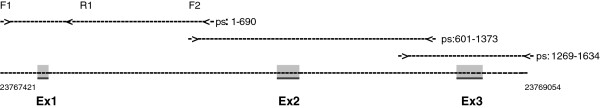
Schematic presentation of primer positions on the rabbit CCL8 ortholog. Primers were designed to cover all exon and intron regions of the proposed Rabbit ortholog of the Human CCL8 gene (1634 bp) [Genbank NC_013687.1:REGION:23767421.23769054]. ‘>’: position of forward primer; ‘<’: of reverse primer; ‘ps’: PCR fragment length.